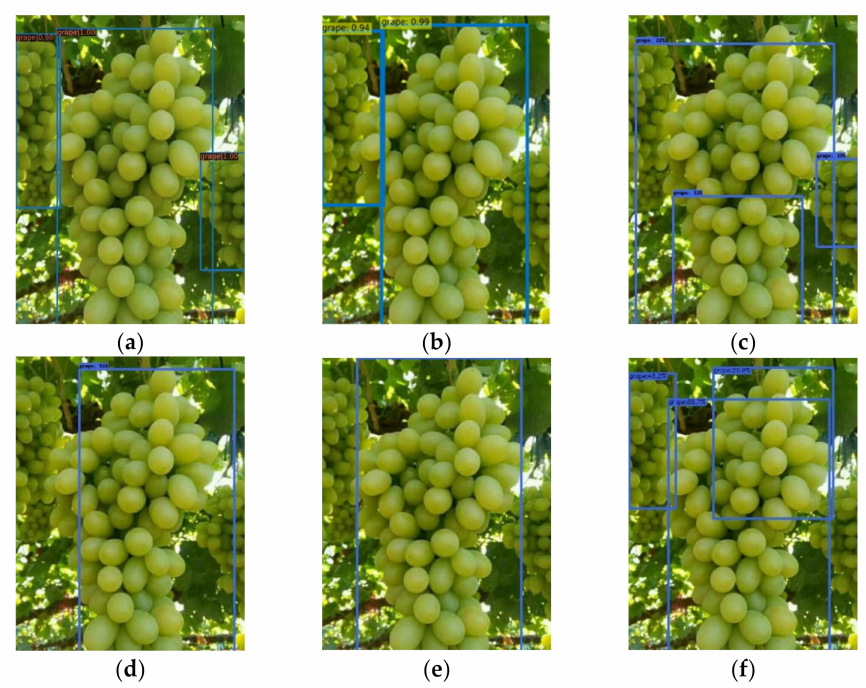
Figure 12. Bunches of green grapes detection in case 3: ( a ) SwinGD, ( b ) DETR, ( c ) YOLOv3-SPP, ( d ) Faster-RCNN, ( e ) SSD, ( f )